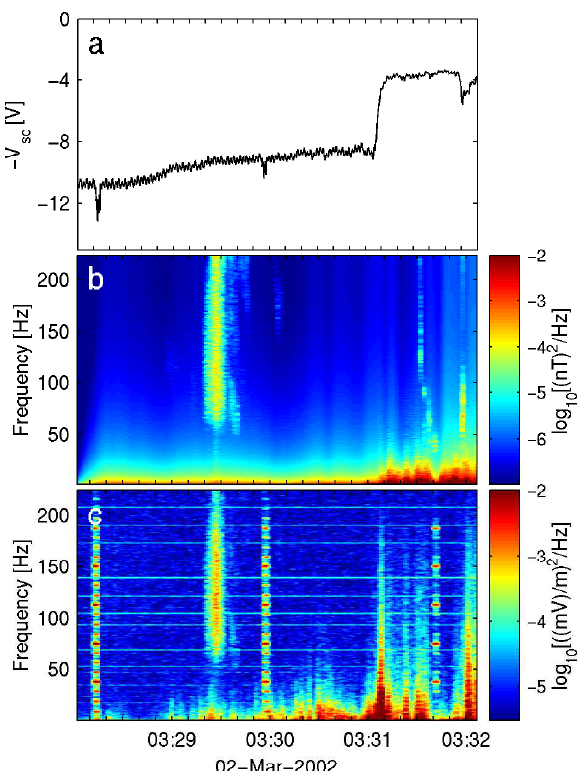
Fig. 1. (a) Probe-to-spacecraft potential (often referred to as the negative of the spacecraft potential, ( − V SC ) versus time. The plasma density is proportional to − V SC and the increase in den- sity associated with the magnetopause crossing is clearly seen. The density on the magnetospheric side is about 3cm − 3 , rising to about 20cm − 3 when the satellite enters the magnetosheath. Data are from EFW. (b) Total magnetic power spectral density (color coded) ver- sus time and frequency (STAFF). The waves we concentrate on are seen at 03:29:30 UT. (c) Total electric power spectral density in the spin plane (color coded) versus time and frequency (EFW). The artificial-looking signals (e.g. at 03:30:00 UT) are caused by the active sounder WHISPER. All data are obtained from Cluster 4.